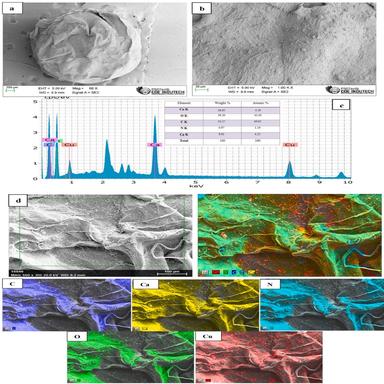
(a & b) SEM micrographs, (c) EDS and (d) Elemental Mapping of the Alg/CuO-gC3N4.